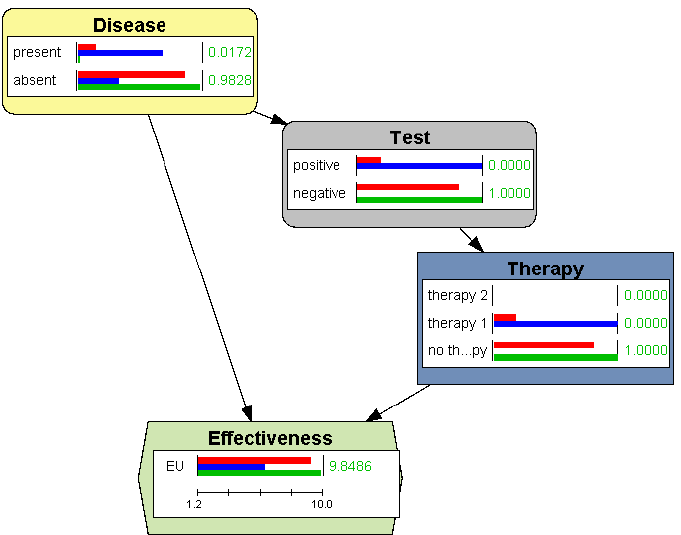
Figure 11. What-if reasoning: OpenMarkov allows the user to analyze what would happen if the decision maker applied a non-optimal policy. The node Therapy is colored in dark blue to indicate that a policy was imposed, instead of allowing the evaluation algorithm find the optimal strategy. The colors of the bars have the same meaning as in Figure